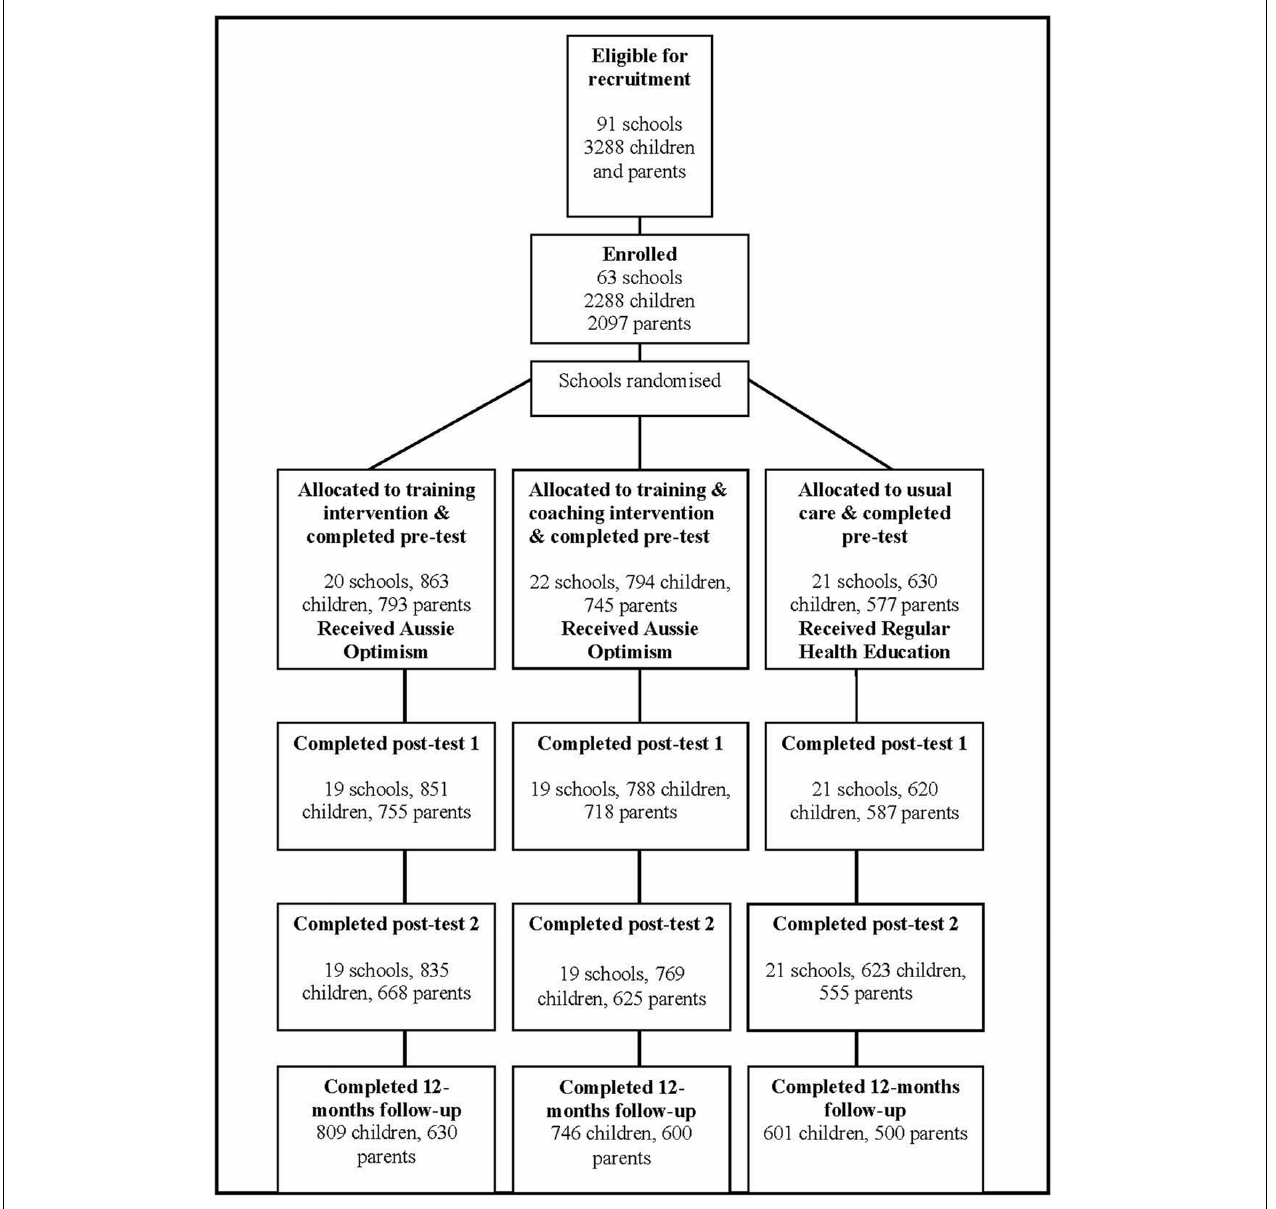
FIGURE 1 | CONSORT diagram of students’ progress through the phases of the randomized control